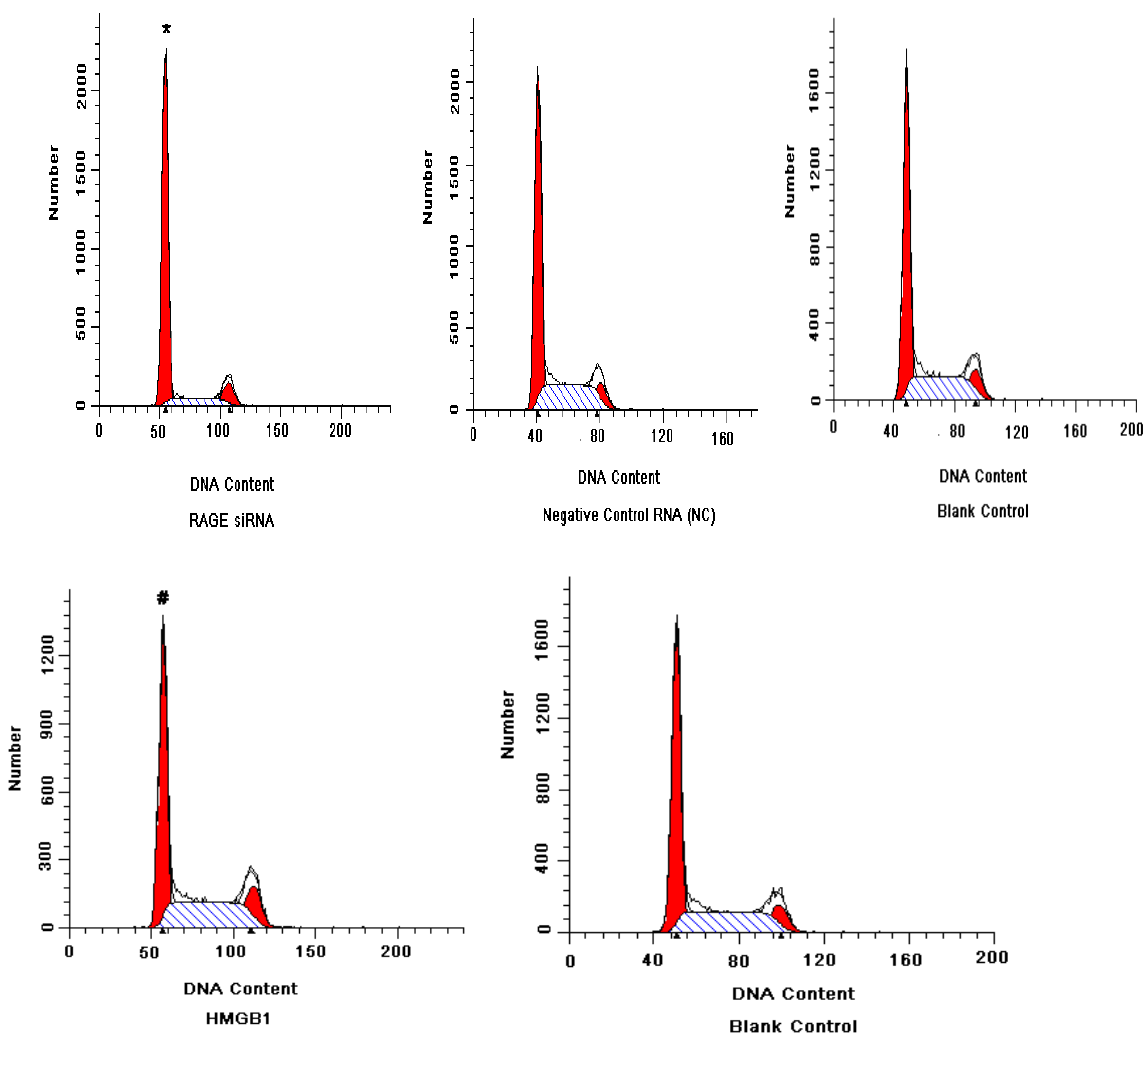
Figure 5. Cell cycle contribution of Huh7 detected by flow cytometry staining treated with RAGE siRNA or HMGB1. RAGE siRNA inhibited DNA synthesis, significantly increased the percentage of cells in G1 phase and significantly decreased the percentage of cells in S-phase 24 h post-treatment ( * p < 0.01). However, HMGB1 induced DNA synthesis, significantly decreased the percentage of cells in G1 phase and significantly increased the percentage of cells in S-phase 24 h post-treatment (# p < 0.05). Three independent measurements were made and